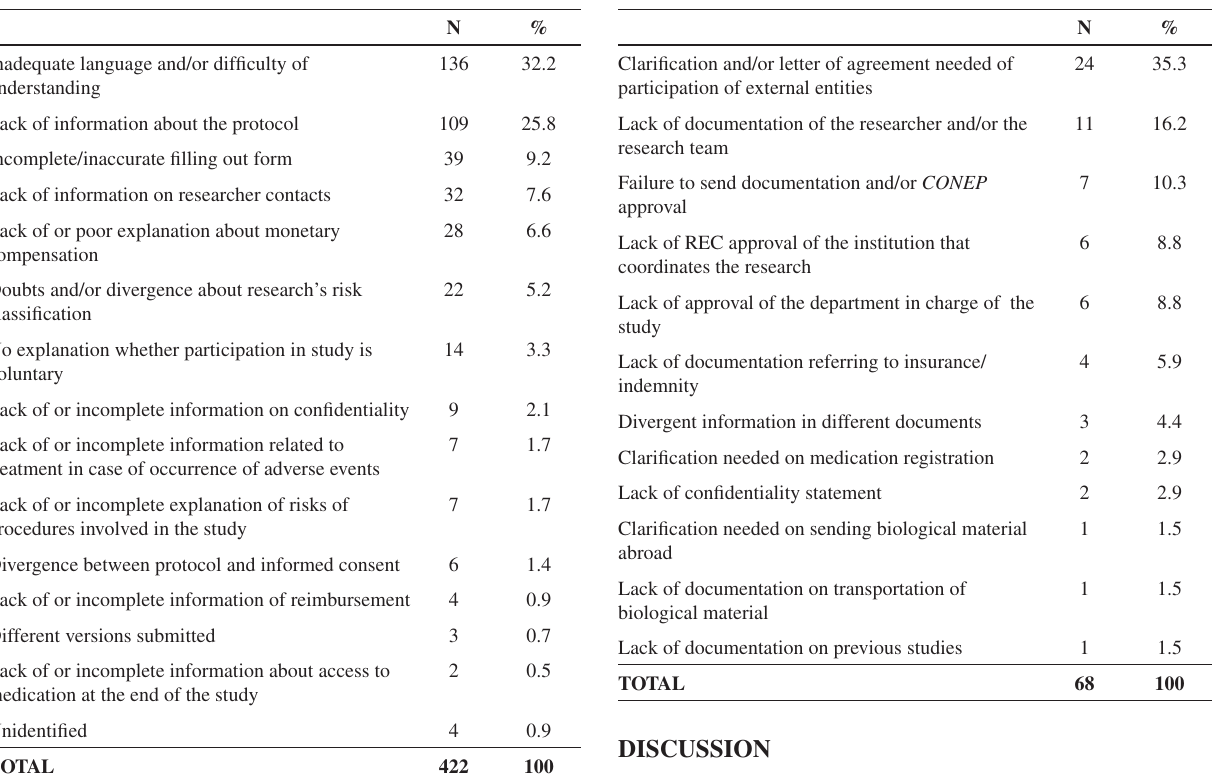
Table 3 - Informed consent-related reasons for returning